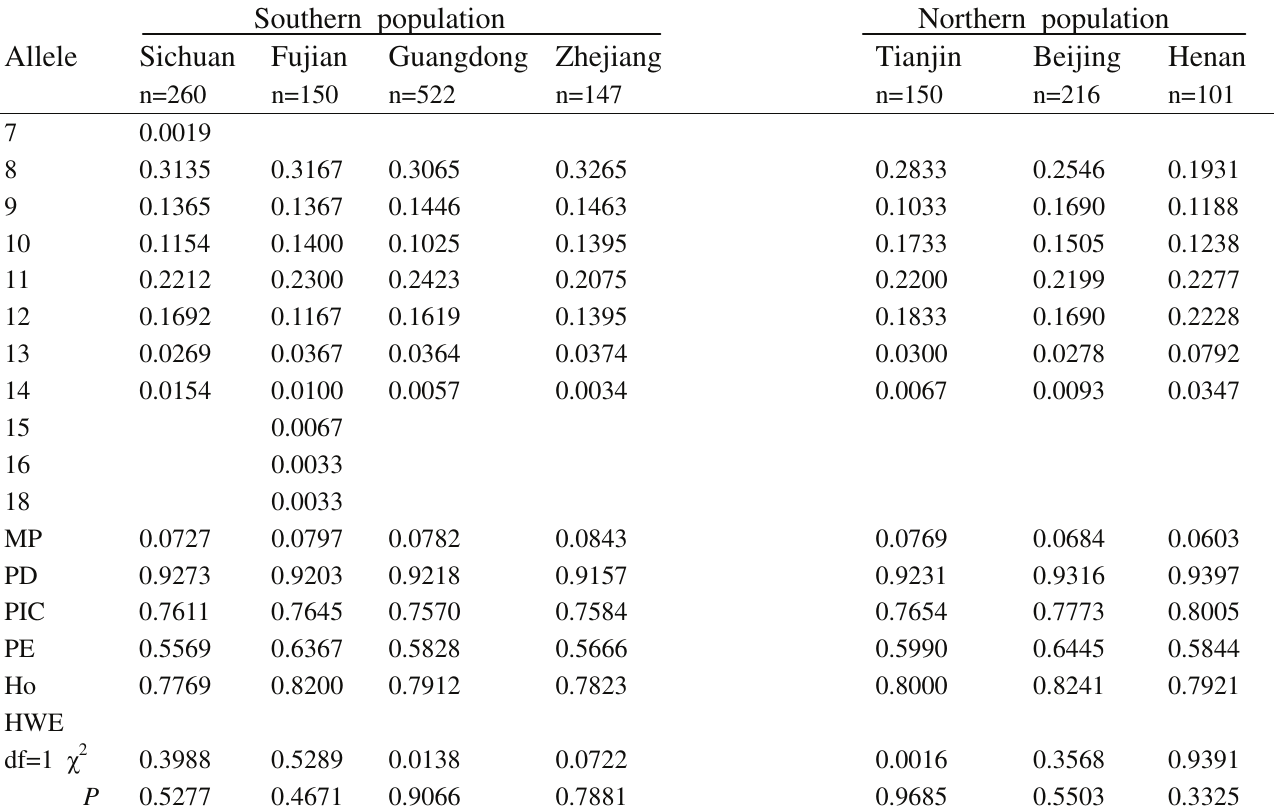
Table S13- Genetic polymorphism at the D13S317 locus for the seven Chinese population